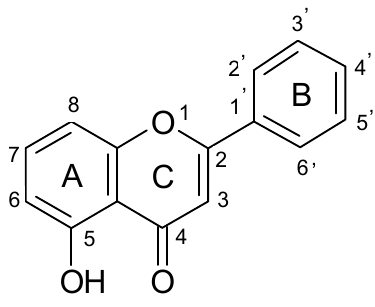
Figure 1. The structure of primuletin